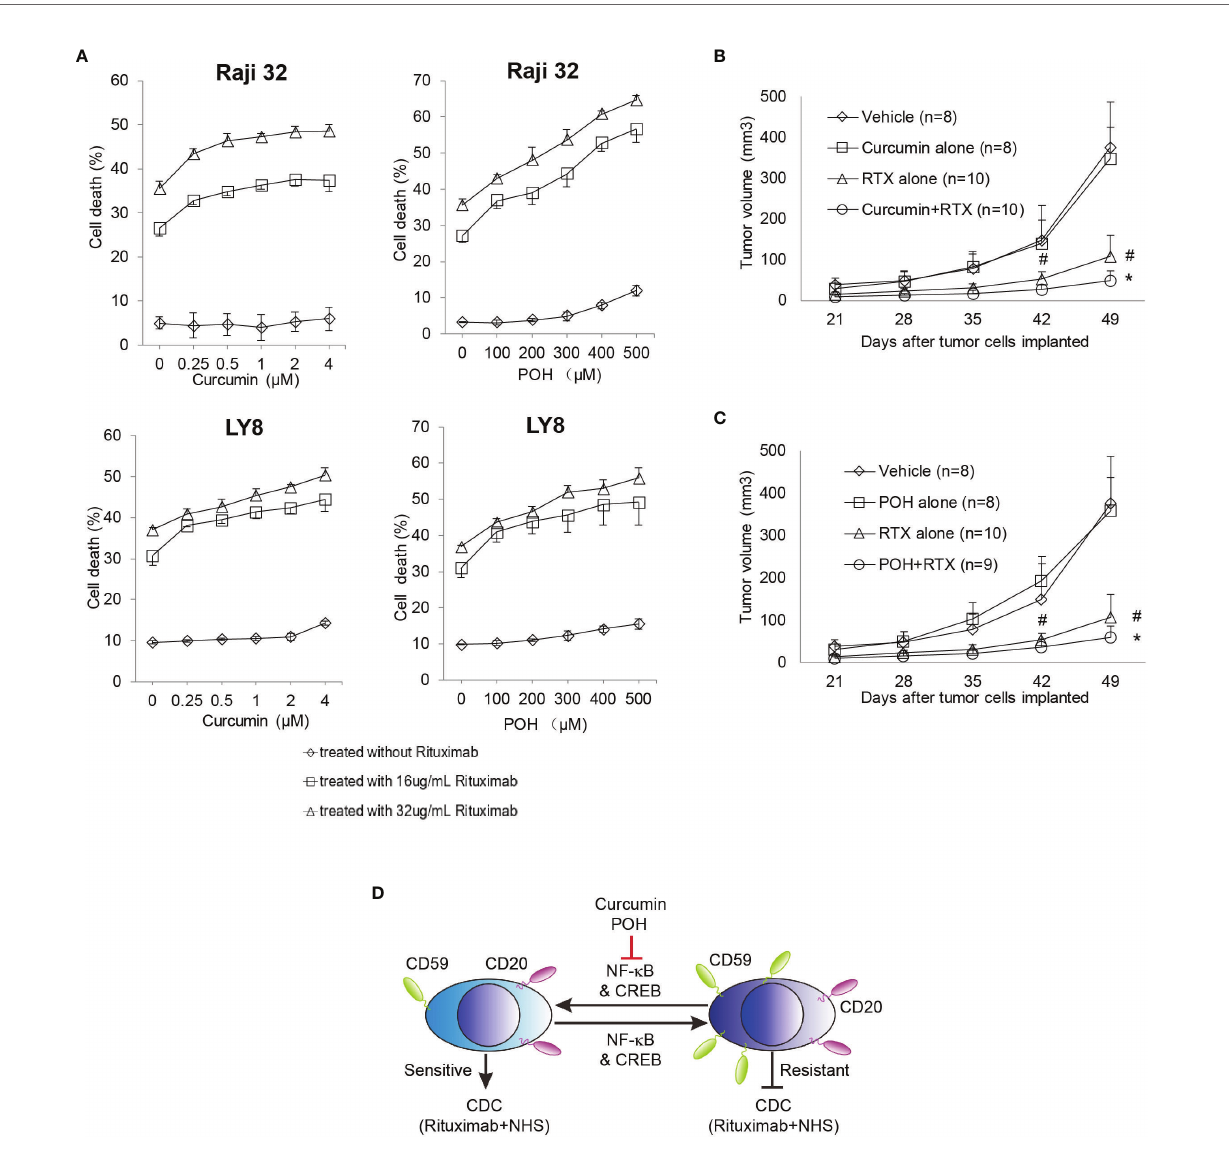
FIGURE 5 | NF- k B inhibitors Curcumin and POH sensitizes the resistant Raji 32 and LY8 cells to rituximab-mediated CDC. (A) Raji 32 and LY8 cells were sensitized to rituximab-mediated CDC after pretreatment with curcumin or POH in vitro . The results represent mean ± SD, n = 3. (B, C) Curcumin (B) and POH (C) synergistically enhanced rituximab antitumor activity against resistant Raji 32 cells in vivo . One-way ANOVA followed by Tukey ’ s post hoc test was used to analyze P values. # P < 0.05 versus vehicle treatment. * P < 0.05 versus rituximab only treatment. The values represent mean ± SEM. (D) Schematic diagram of CD59 transcriptional regulation by NF- k B and CREB signaling. The natural chemicals curcumin and POH suppress the expression of CD59 but not CD20 via inhibition of NF- k B and CREB pathways, leading to sensitization of resistant Raji32 and LY8 cells to rituximab-mediated CDC. NHS, Normal Human